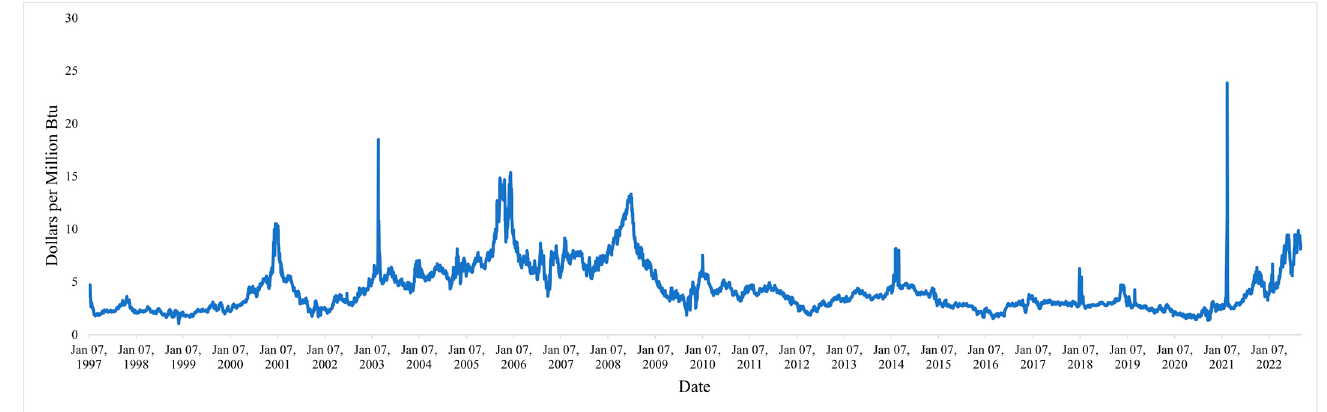
Figure 7. Daily natural gas price trend from January 1997 to September 2022.